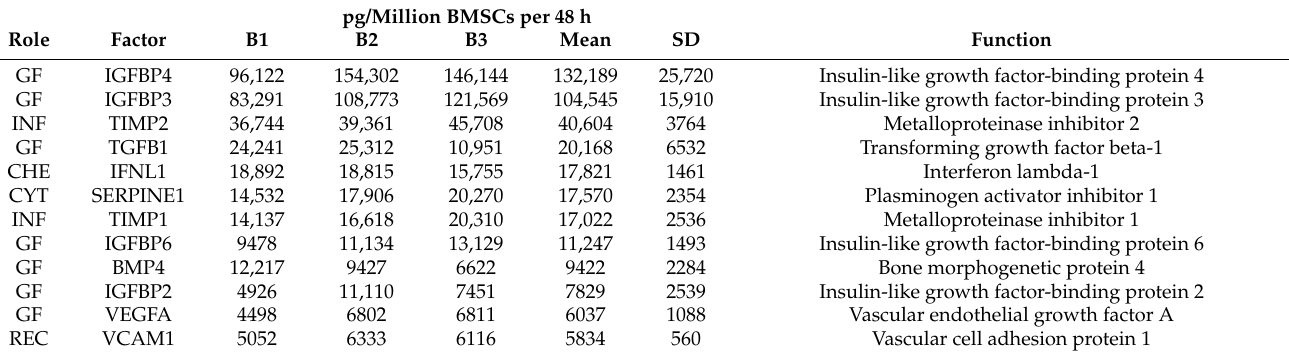
Table 1. BMSCs secreted factors detected in all donors and ordered by abundance of the mean